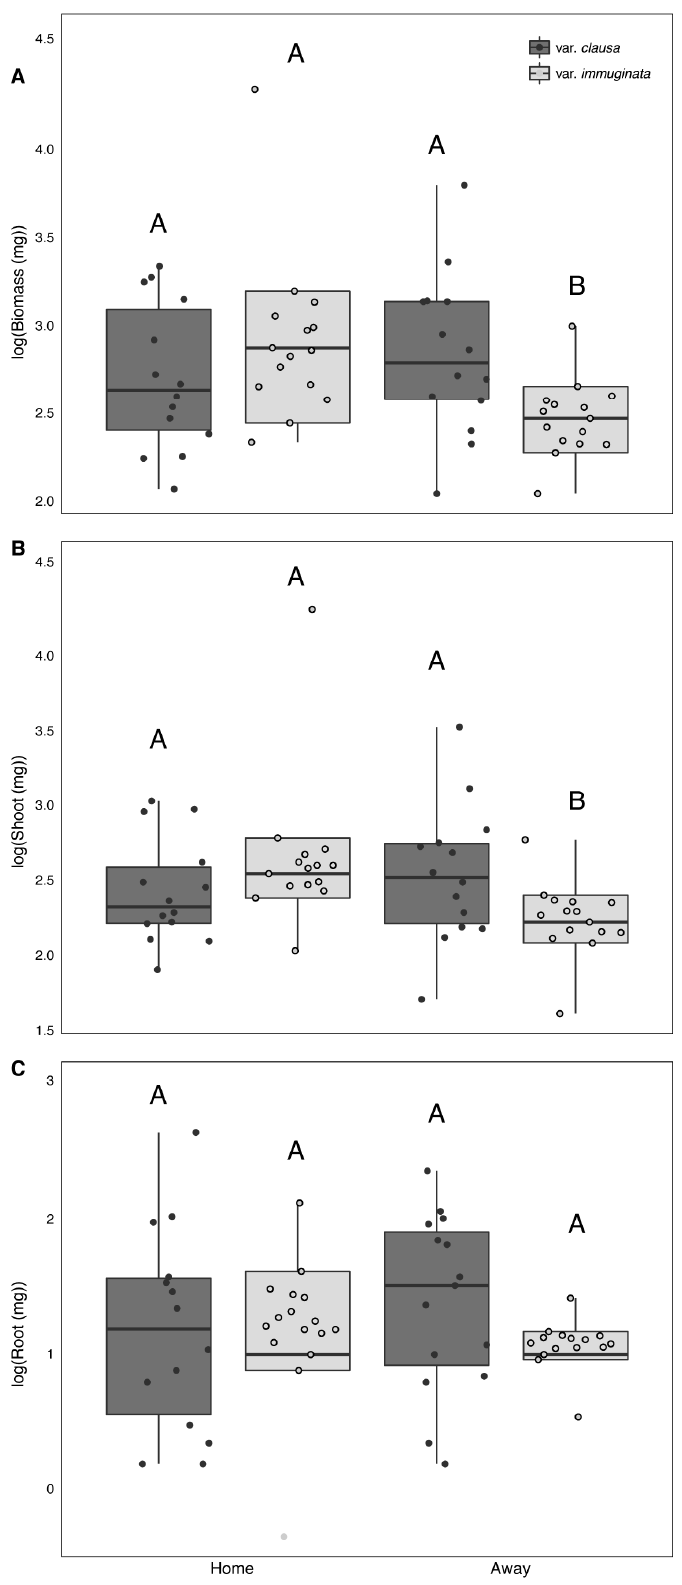
Figure 5. Total plant biomass ( A ), shoot biomass ( B ), and root biomass ( C ) for Pinus clausa seedlings grown in soil from their own variety (“Home”) or soil from the other variety (“Away”). Each treatment combination (variety × soil source) consists of 15 seedlings (3 per block). Letters indicate differences based on Tukey’s HSD